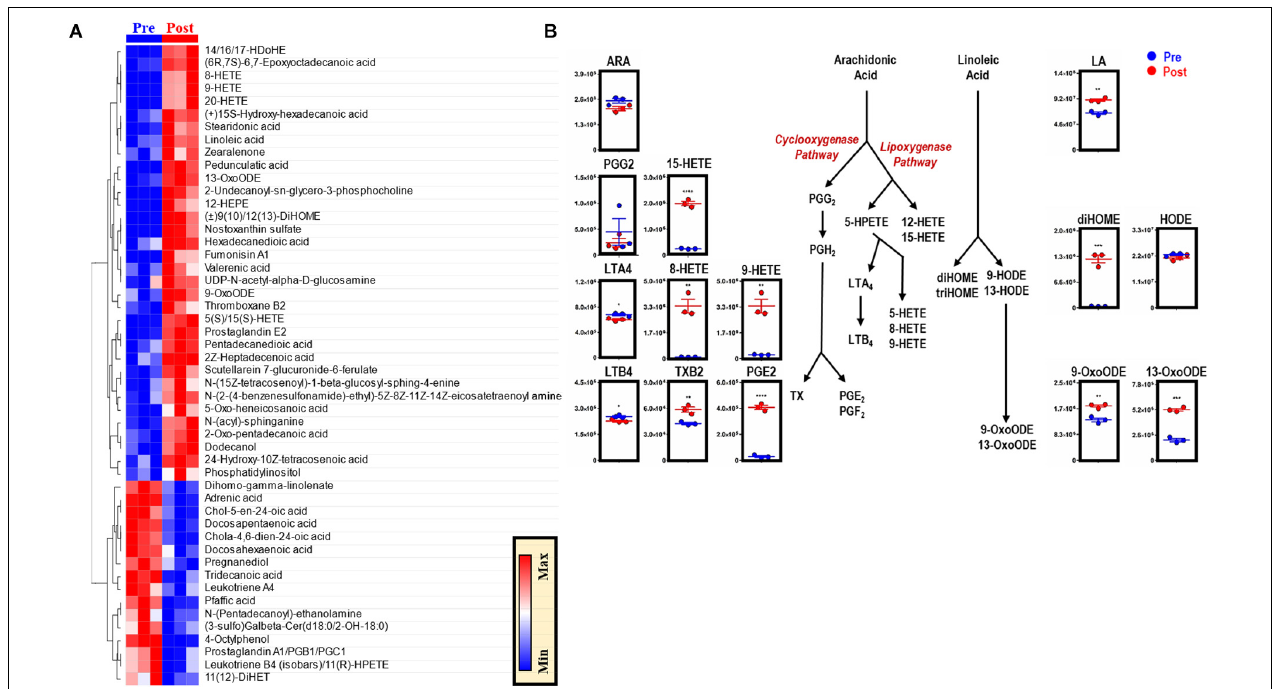
FIGURE 5 | EP reprograms arachidonate and linoleate metabolism in BMDMs. The top 50 metabolites in BMDMs that are part of eicosanoid and oxylipin synthesis and change significantly following EP (A) . Values are plotted as a hierarchically-clustered heat map based on p -value. Overview of eicosanoid and oxylipin metabolism, stemming from arachidonic acid (ARA) and linoleic acid (LA) (B) . For all plots, the y-axis represents relative intensity (a.u.). * p ≤ 0.05; ** p ≤ 0.01; *** p ≤ 0.001 (unpaired t -test, 2-tailed distribution). PGG2, prostaglandin G2; PGH2, prostaglandin H2; PGE2, prostaglandin E2; PGF2, prostaglandin F2; HETE, hydroxyeicosatetraenoic acid; HPETE, hydroperoxyeicosatetraenoic acid; LTA4, leukotriene A4; LTB4, leukotriene B4; TX, thromboxane; TXB2, thromboxane B2; diHOME, dihydroxyoctadecanoic acids; triHOME, trihydroxyoctadecanoic acids; HODE, hydroxyoctadecadienoic acid; OxoODE, oxooctadecadienoic acid.